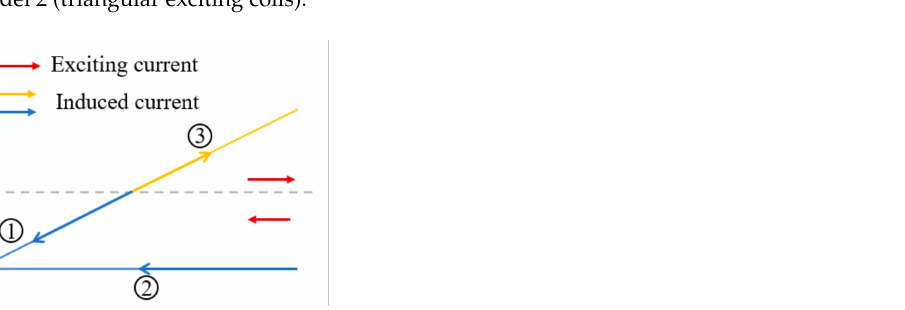
Figure 8. Simulation results of the crack angle detection. ( a ) Model 1 (rectangular exciting coils); ( b ) Model 2 (triangular exciting coils).